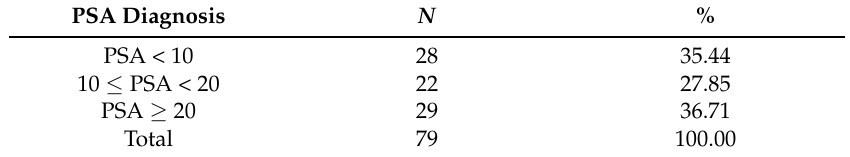
Table 2. Frequency of important clinical parameters for the study cohort. Pre-treatment PSA value.